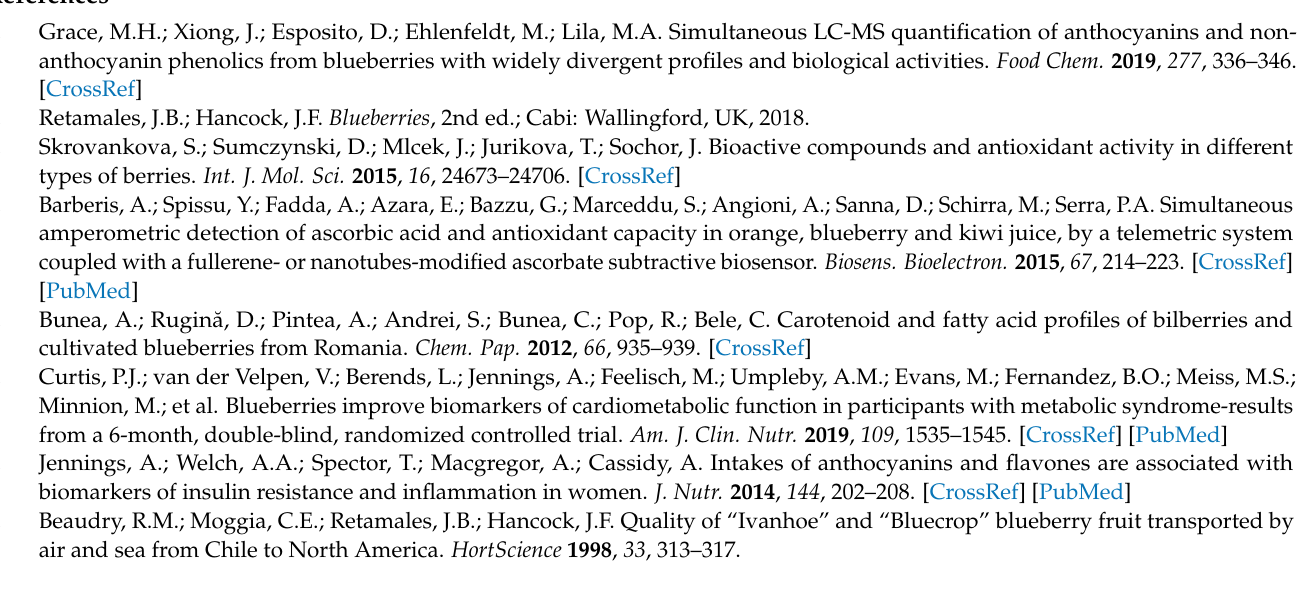
storage. Table S2: Hydroxycinnamic acids, flavan-3-ols, flavonols, anthocyanins and total phenolics of blueberry fruit for the air control and the controlled atmospheres of 5% CO 2 , 5% O 2 , 90% N 2 (5% CO 2 ), 15% CO 2 , 5% O 2 , 80% N2 (15% CO 2 ), and 25% CO 2 , 5% O 2 , 70% N 2 (25% CO 2 ), according to length of